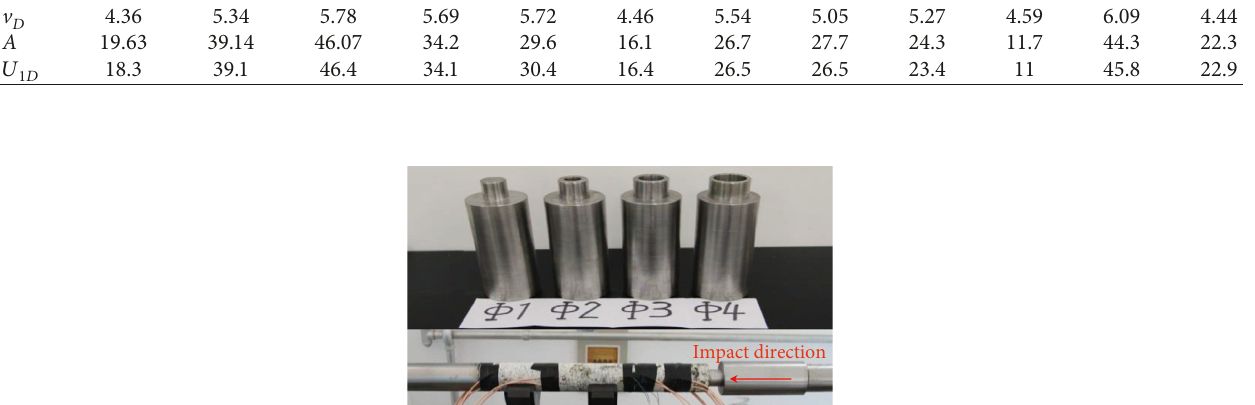
Table 1: Fitting coefficient, A , and elastic energy at the 1 D position.